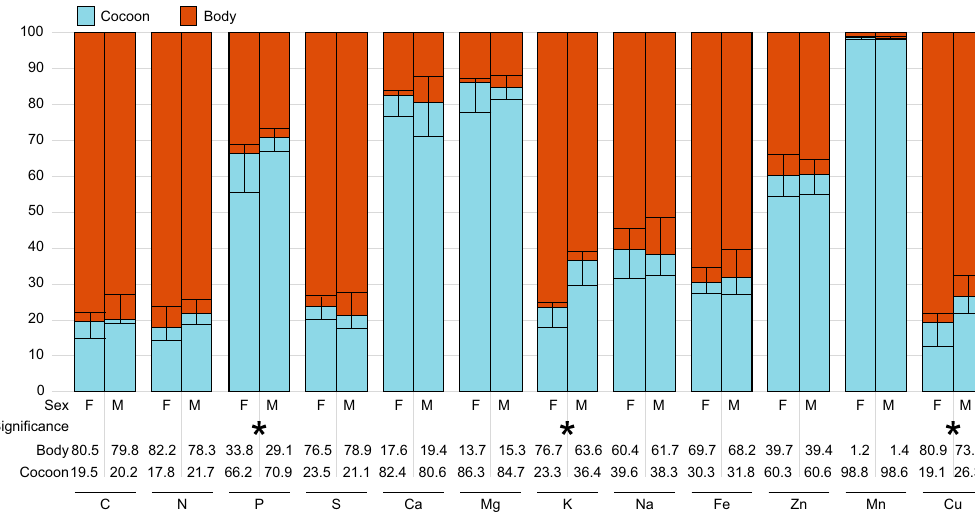
Figure 5. The allocation of elements assimilated from food differs between the sexes. Pattern of allocation of assimilated elements calculated for the total amount of elements composing the total production (body + cocoon): 100% = Mx body + Mx cocoon . Mx = mass of element x. For every sex, N = 7. Statistical significance was calculated for each element separately (Mann–Whitney U, p < 0.05) and is indicated by asterisks. Median values are shown as lines dividing the body and cocoon, and whiskers show the minima and maxima. Median values for the percentage of an element allocated to the body/cocoon are given below the figure.